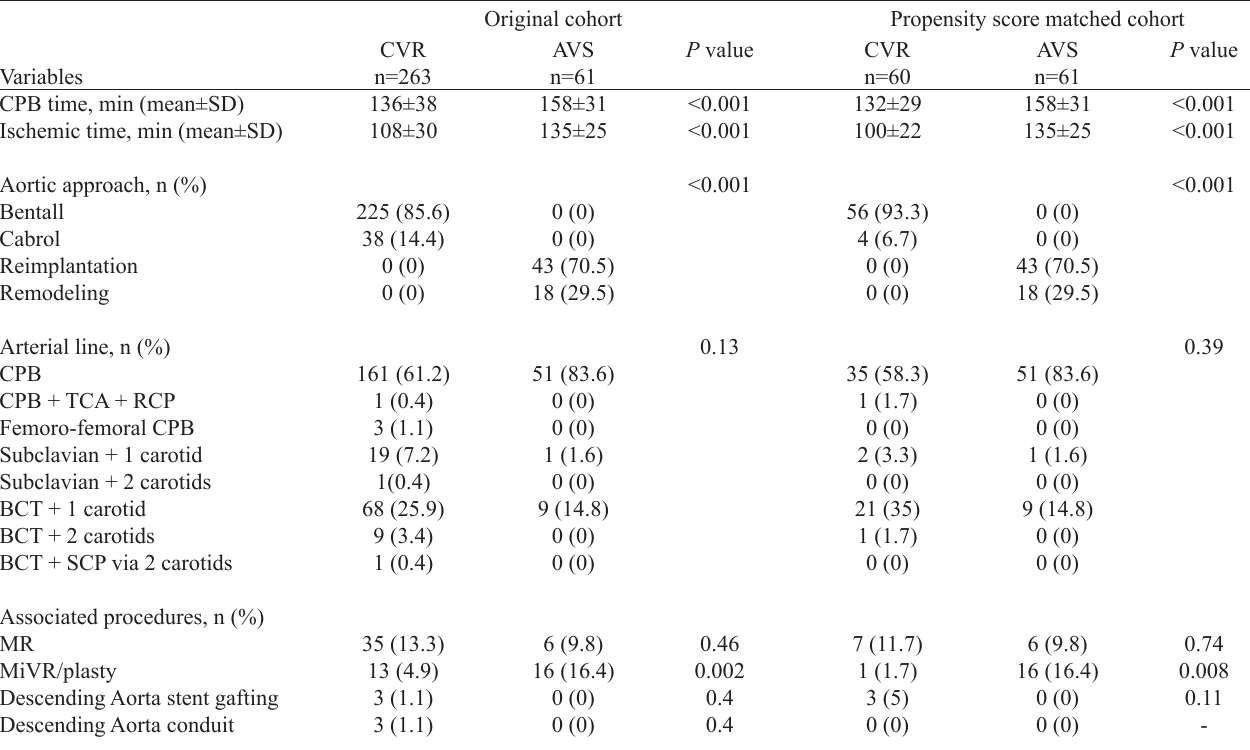
2. Intraoperative data of patients from the original CVR and AVS groups and propensity score matched